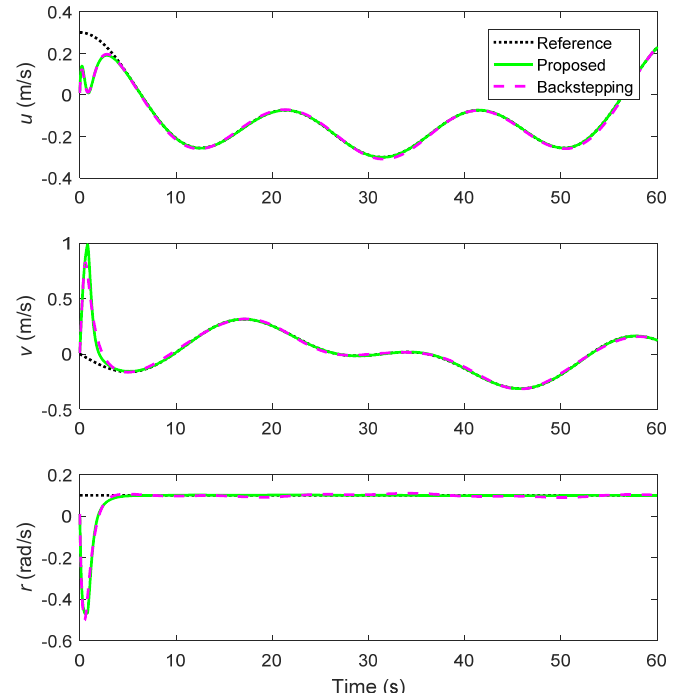
Figure 13. Profile of the velocity tracking (Case 2).